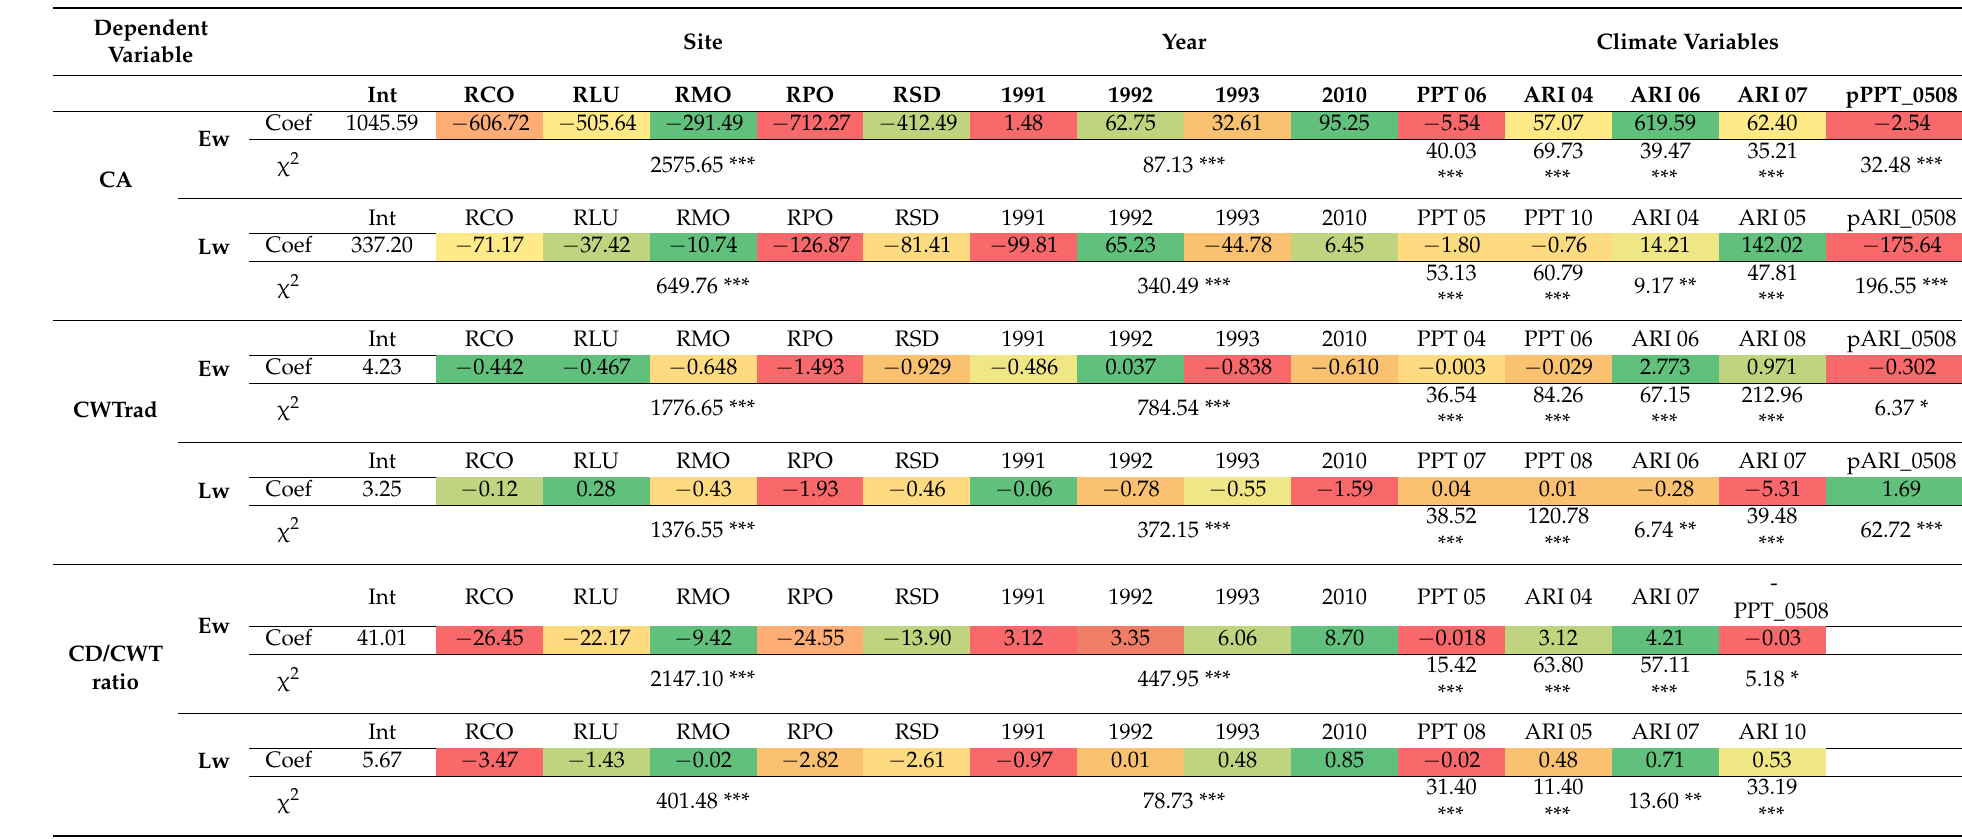
Table 2. Linear mixed effect models (LMMs) and likelihood ratio tests conducted on the fixed factors of site, year, and climate factors to test their effects on the wood’s anatomical features. Heat maps correspond to coefficient (Coef.) relations between the climate covariates (PPT, ARI) and among factor levels of the site (S) and year (Y) variables. Color hues are from the minimum to the maximum, from red–orange–yellow and light to dark green, proportionally. Reference site is HFE, reference year is 1990, both referred by Int